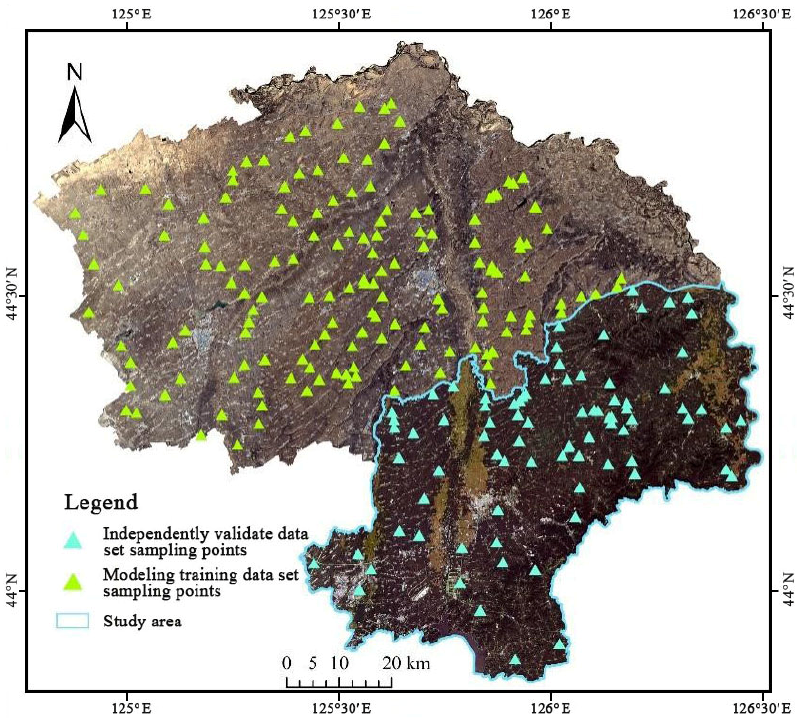
Figure 1. Distribution map of sampling points.